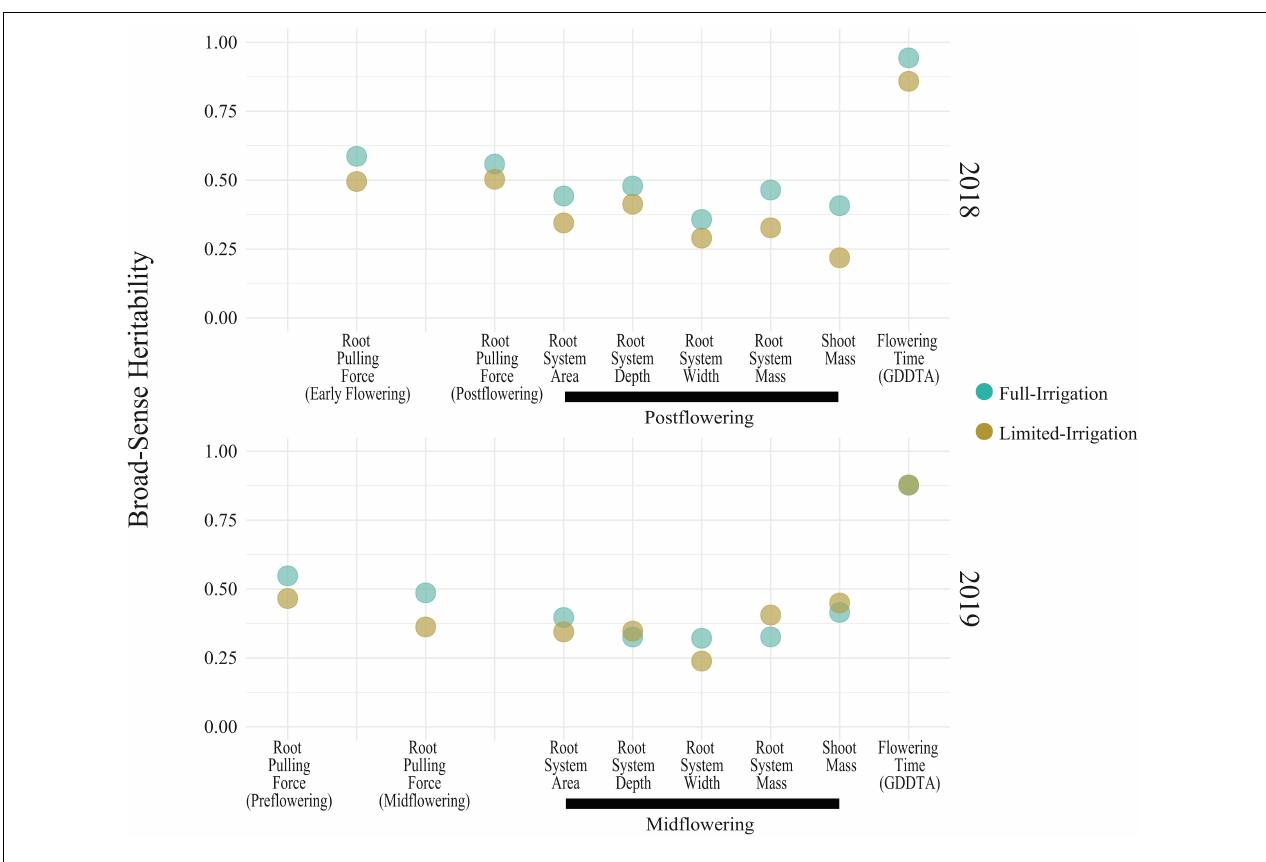
FIGURE 3 | Broad-sense heritability of RPF and other root traits in the